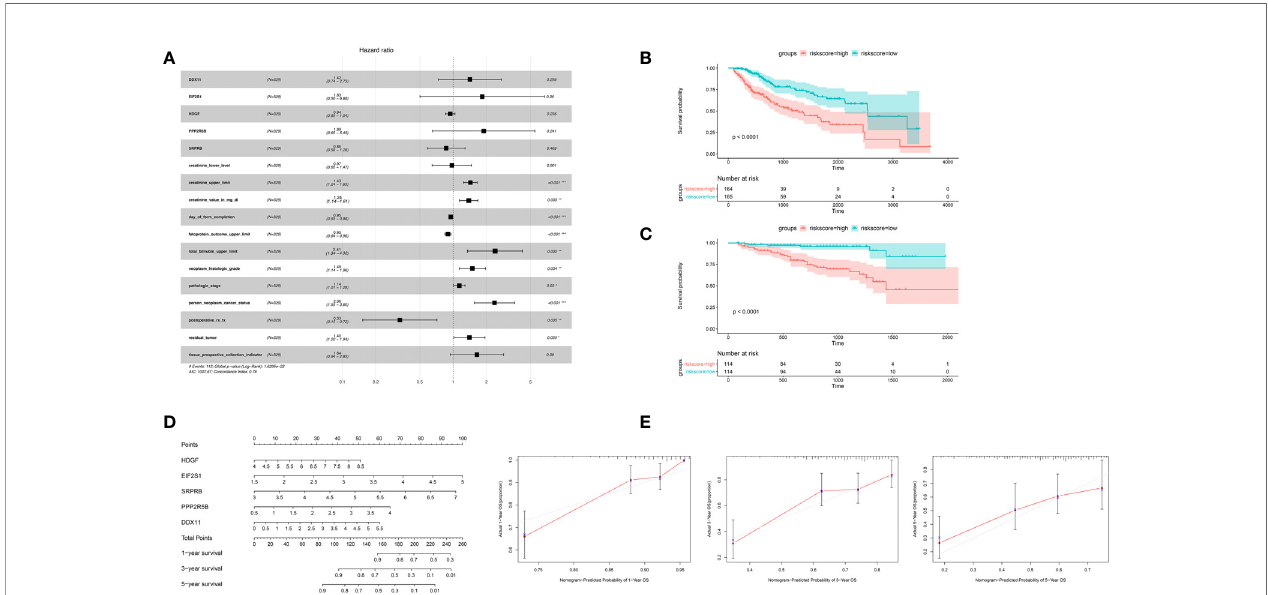
FIGURE 4 | Identi fi cation of independent prognostic factors and establish forecast nomogram. (A) Forrest chart of HCC multivariate cox analysis in the TCGA cohort. (B) Kaplan-Meier curve of 5 gene markers in the TCGA population for the training set. (C) Kaplan-Meier curve of 5 gene markers in the ICGC population for the testing cohort. (D) Establishment of nomogram combining 5 gene markers in the TCGA cohort. (E) The Calibration curves, used for internal veri fi cation nomogram in the TCGA cohort. *p < 0.05, **p < 0.01, ***p < 0.001.